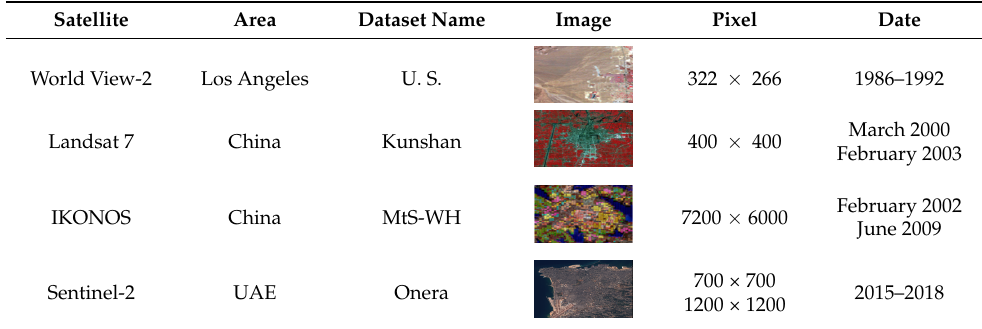
Table 4. Illustration of wide area datasets.